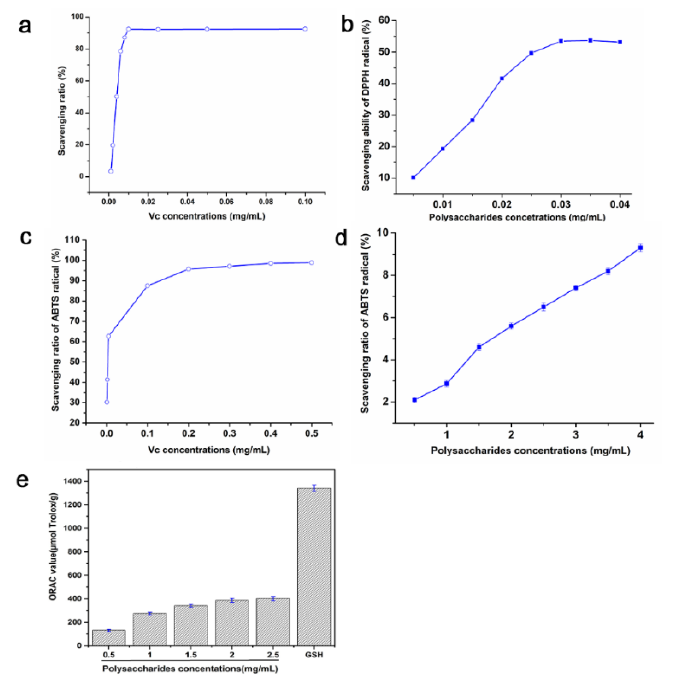
Figure 4. DPPH radical scavenging effects of Vc ( a ) and Pan ( b ); ABTS radical scavenging effects of Vc ( c ) and Pan ( d ); ORAC free radical scavenging via GSH and different concentrations of Pan ( e ). The ORAC of Pan at 2.5 mg/mL was 375.29 ± 13.8 µ M Trolox/g (Figure 4e), which